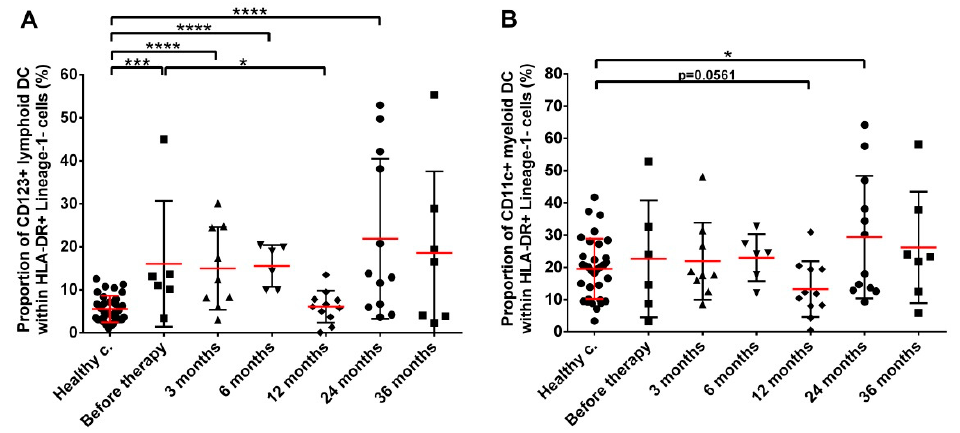
Figure 7. Persistent increase in the fraction of lymphoid DCs and milder changes in myeloid DCs in prostate cancer patients. ( A ) Lymphoid DCs, ( B ) Myeloid DCs. Blood collection, processing and immune phenotyping were carried out as described in the Materials and Methods at the indicated time points relative to brachytherapy. n (healthy controls) = 36, n (cancer patients) = 12. Significant differences were indicated with * ( p < 0.05), *** ( p < 0.001) and **** ( p < 0.0001).